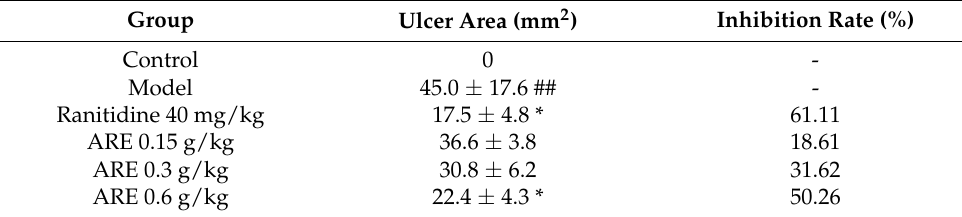
Figure 8. Results of gastric morphology. ( A ) Control group. ( B ) Model group. ( C ) Ranitidine group. ( D ) ARE 0.15 g/kg group. ( E ) ARE 0.3 g/kg group. ( F ) ARE 0.6 g/kg group. ARE, Aucklandia Radix ethanol extract. Table 5. Effects of ARE against indomethacin-induced